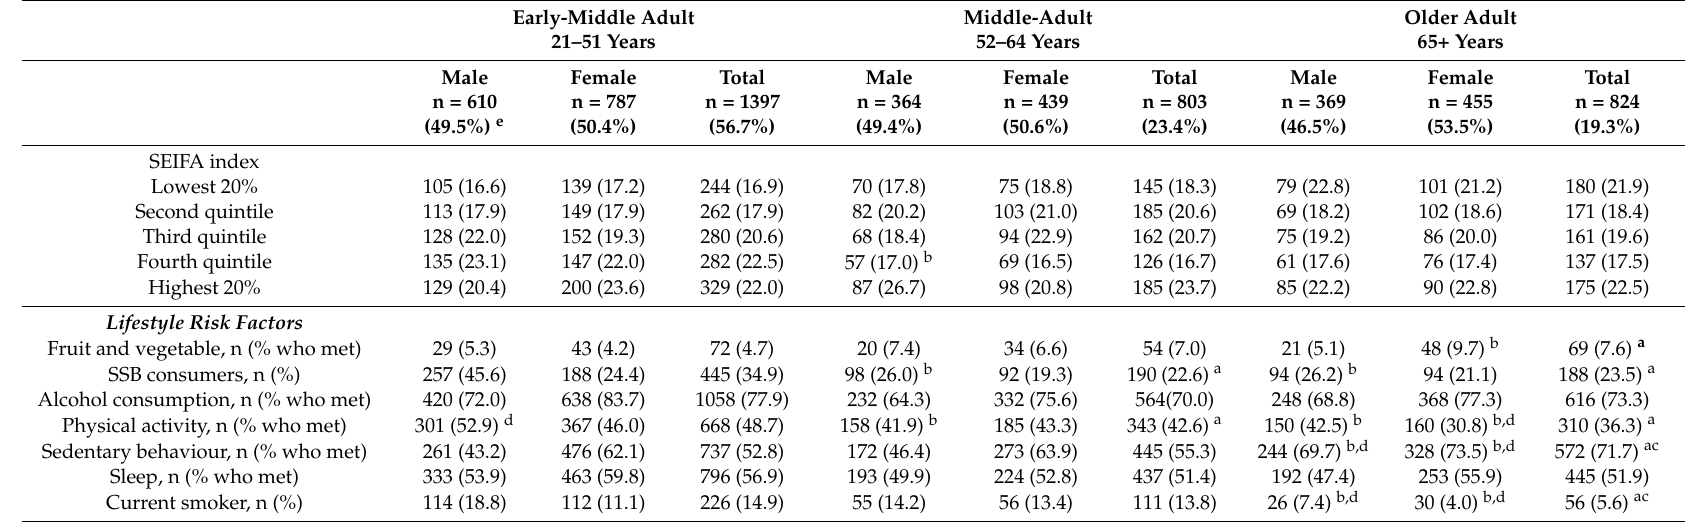
Table 2. Demographic and lifestyle risk factors of early-middle aged adults (21–51 years, n = 1397), middle aged-adults (52–63 years, n = 803) and older adults (65+ years, n = 824) in Australia